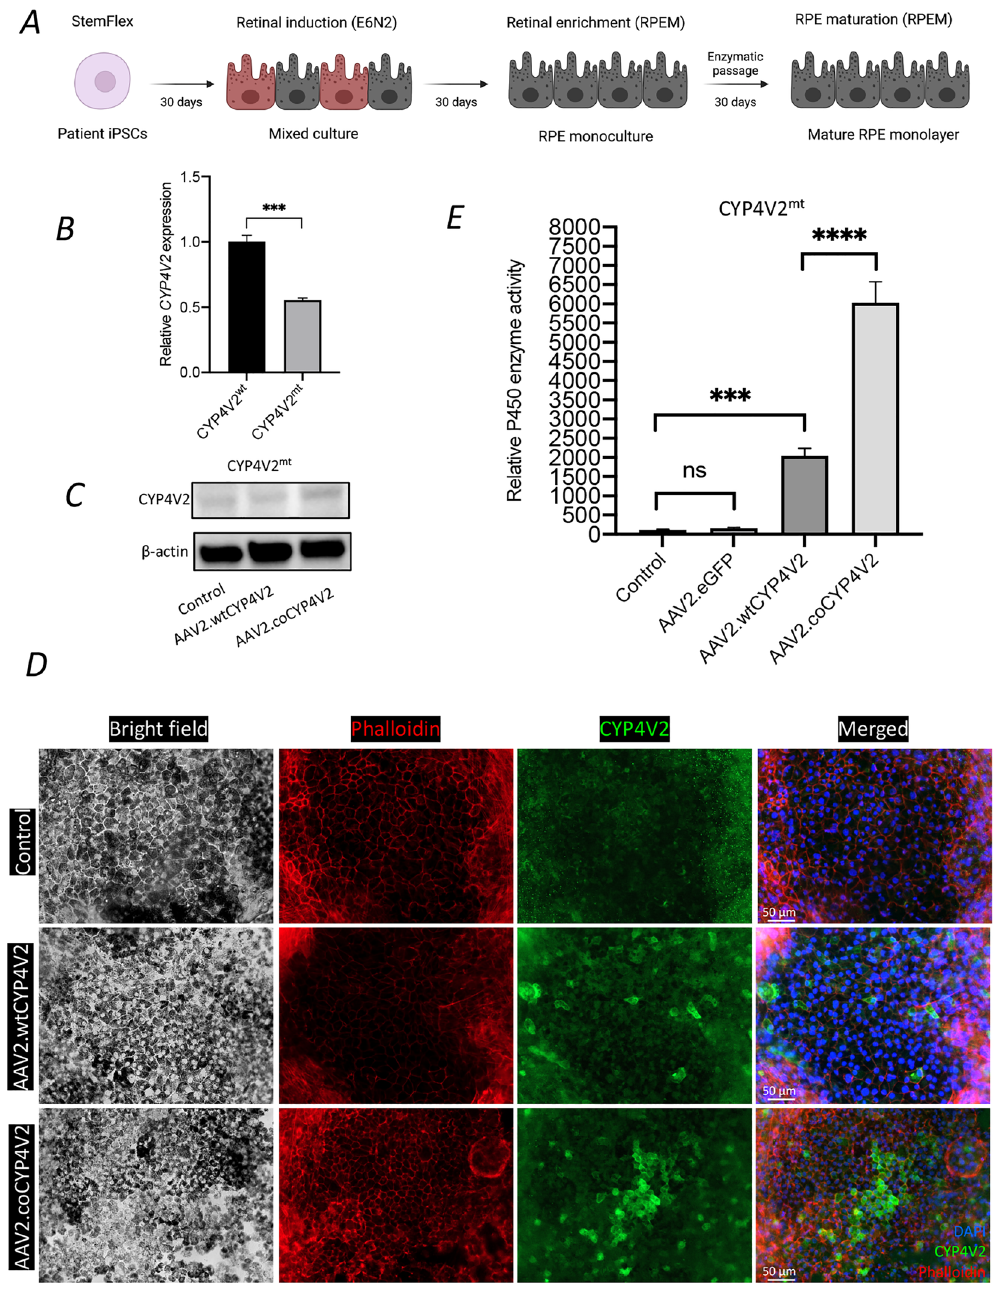
Figure 4. CYP4V2 expression in BCD iPSCs-derived RPE cells. ( A ) A schematic summary of the process of generation of iPSCs-RPE cells. ( B and C ) mRNA and protein expression of CYP4V2 was lower in BCD iPSCs-derived RPE (CYP4V2 mt ) cells than in control (CYP4V2 wt ) cells, as assessed by qPCR and western blot, respectively. ( D ) Immunocytochemistry showed stronger expression of CYP4V2 in BCD iPSCs-derived RPE cells transduced with AAV2.coCYP4V2 compared to those transduced with AAV2.wtCYP4V2 and untransduced controls. ( E ) CYP4V2 enzyme activity was quantified in BCD iPSCs-derived RPE cells transduced with AAV2.wtCYP4V2, AAV2.coCYP4V2 and control AAV2.eGFP, and data are presented as mean ± SEM (n = 12). *** p < 0.0001. ns, not